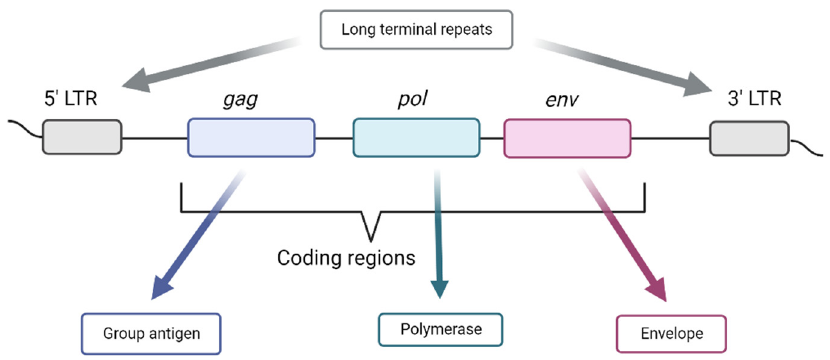
Figure 3. Main components of a human endogenous retrovirus (HERV). LTR—long terminal repeat.